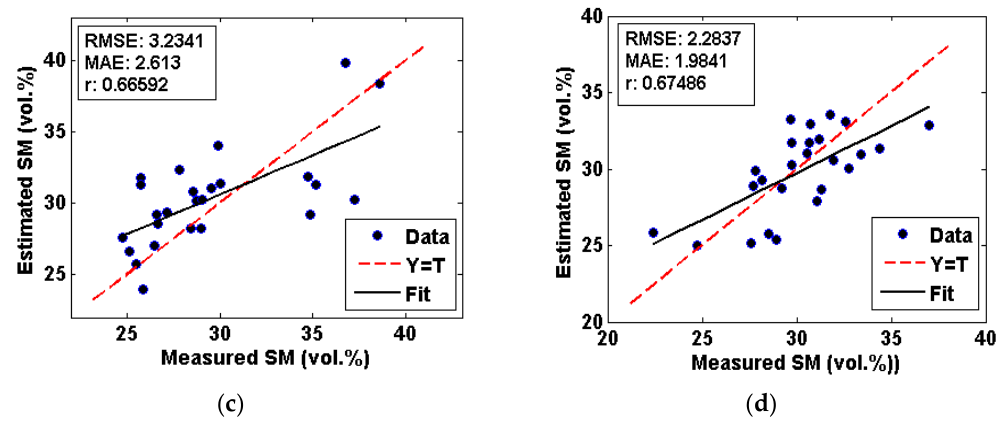
Figure 10. The relationship between measured and estimated SM over testing areas 1–4 for Dataset 2 ( a – d ), respectively.